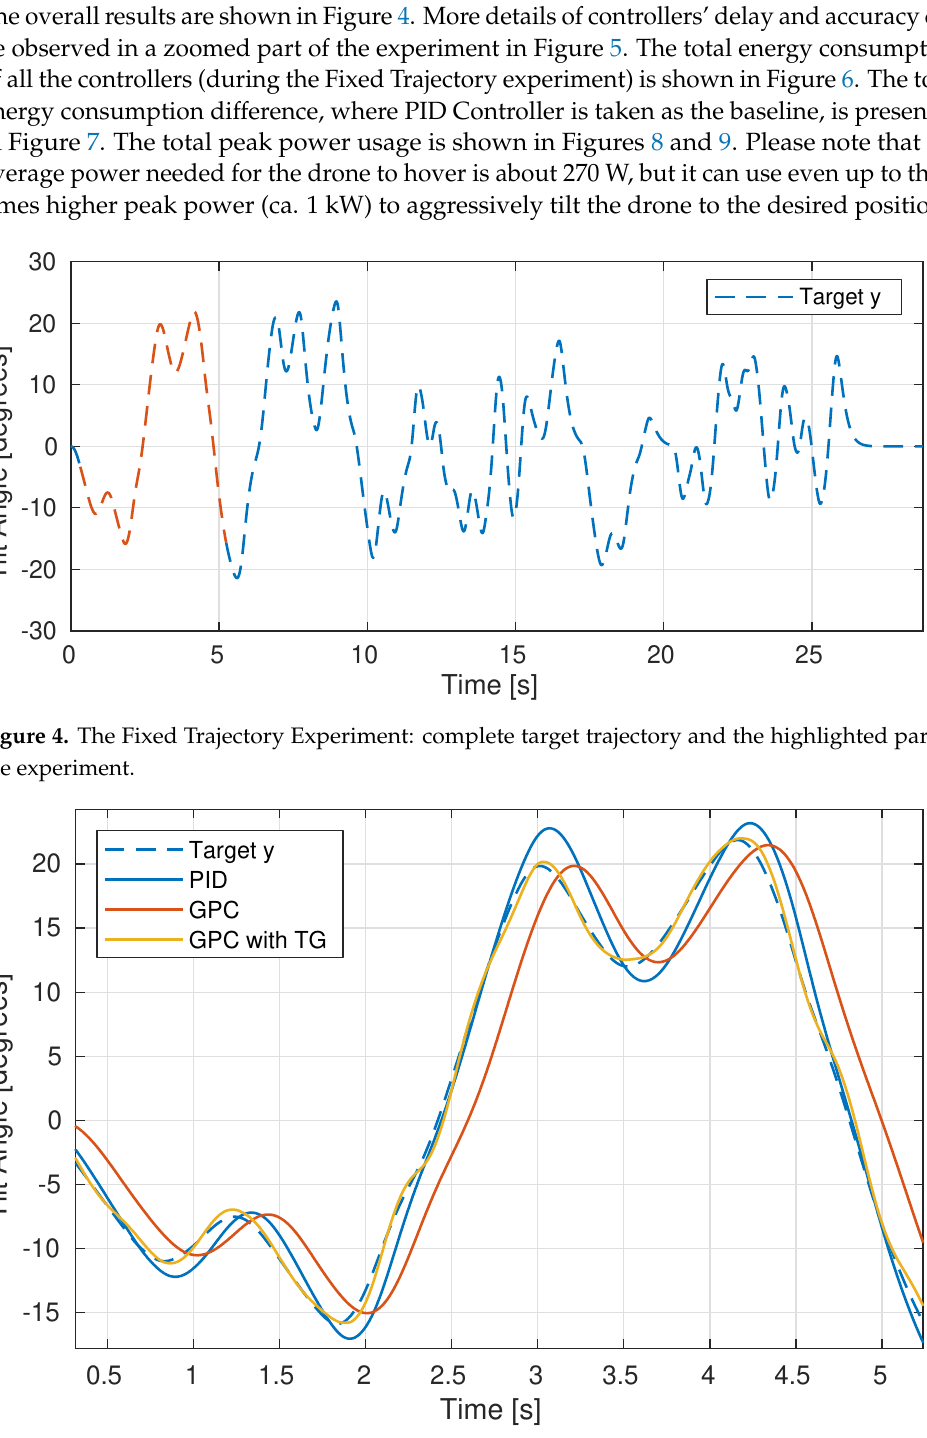
Figure 5. Performance of all the controllers for a selected part of the Fixed Trajectory